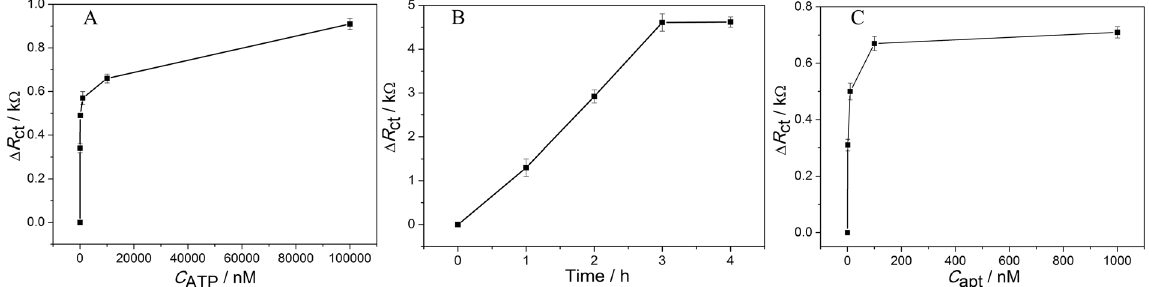
Figure 3. ( A ) The Δ R ct value responses to different concentrations of ATP in absence of Ce-MOF; the Δ R ct value responses to different reaction time between ATP and its aptamer ( B ) and aptamer concentrations ( C ) based on Ce-MOF.